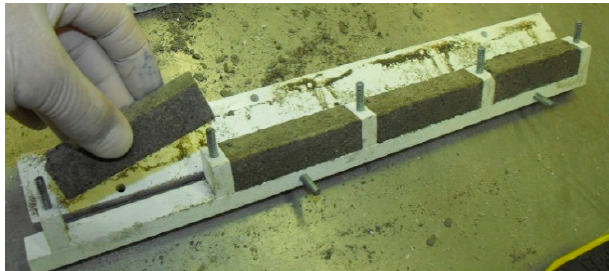
Figure 1. Small-scale prismatic moulds and specimens.